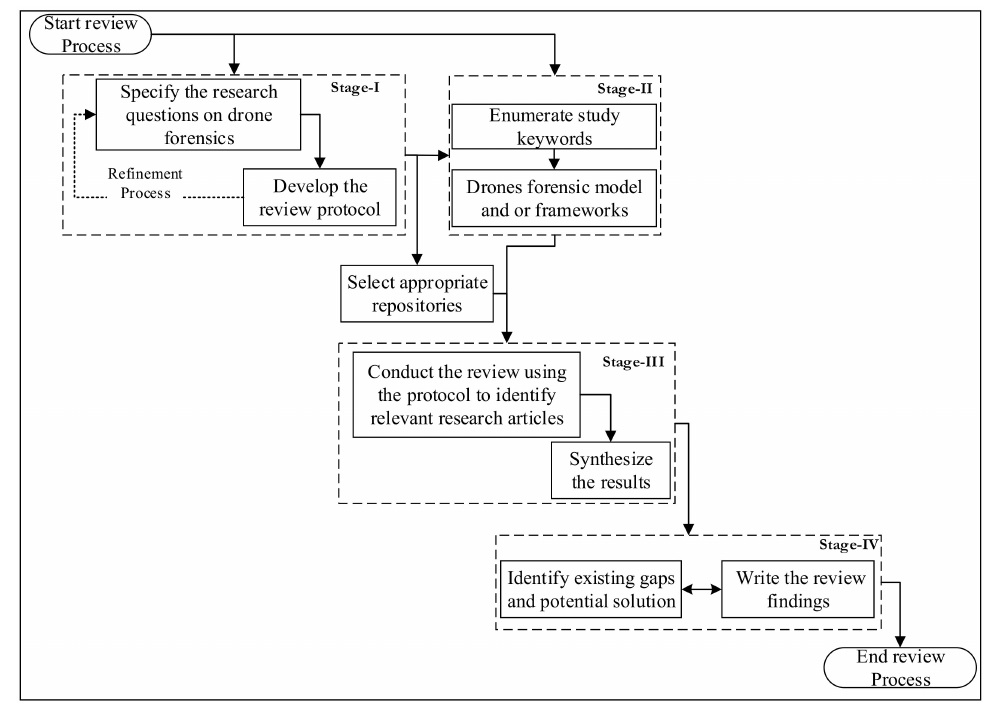
Figure 2. Conceptualized